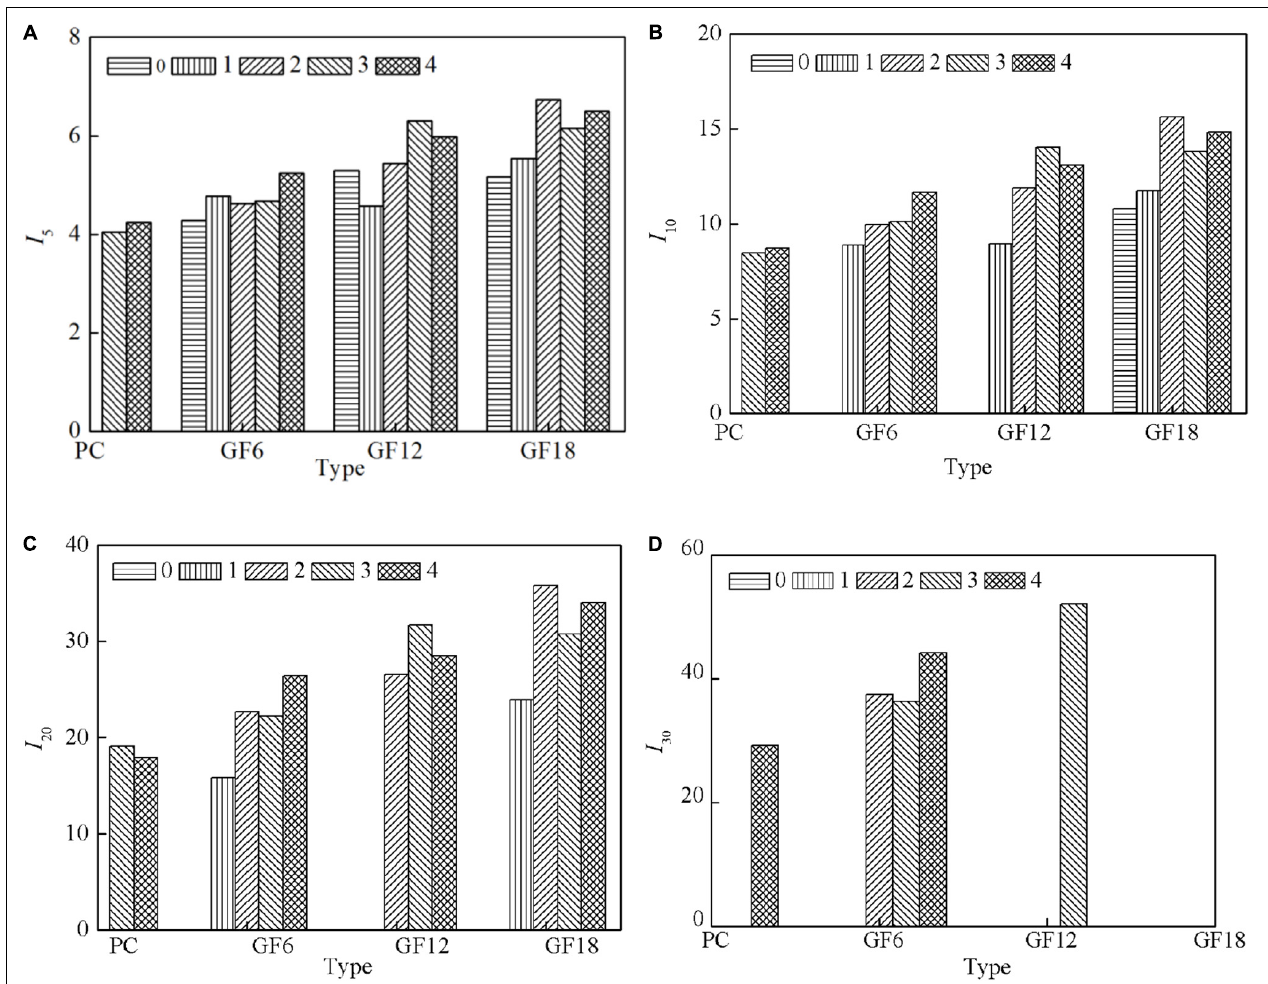
FIGURE 10 | Effects of textile and short fibers on toughness index of the BTRC sheets. (A) I 5 , (B) I 10 , (C) I 20 , (D) I 30